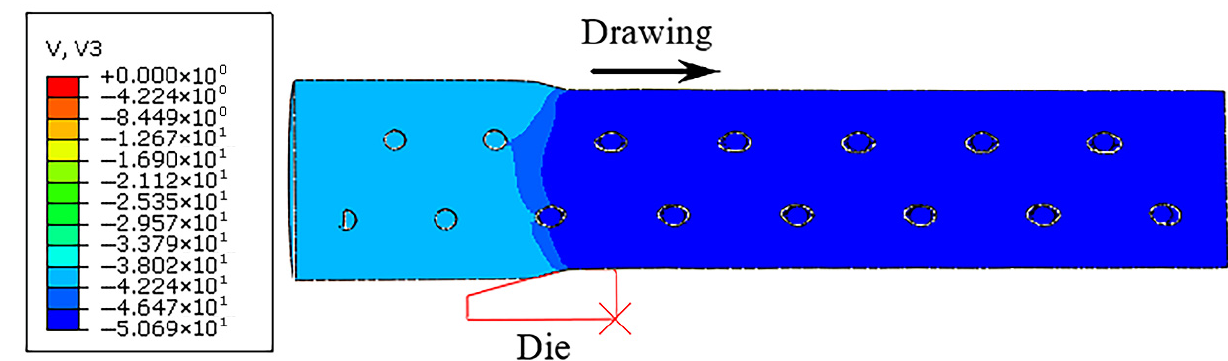
Figure 8. Velocity distribution (V3) in drawing.